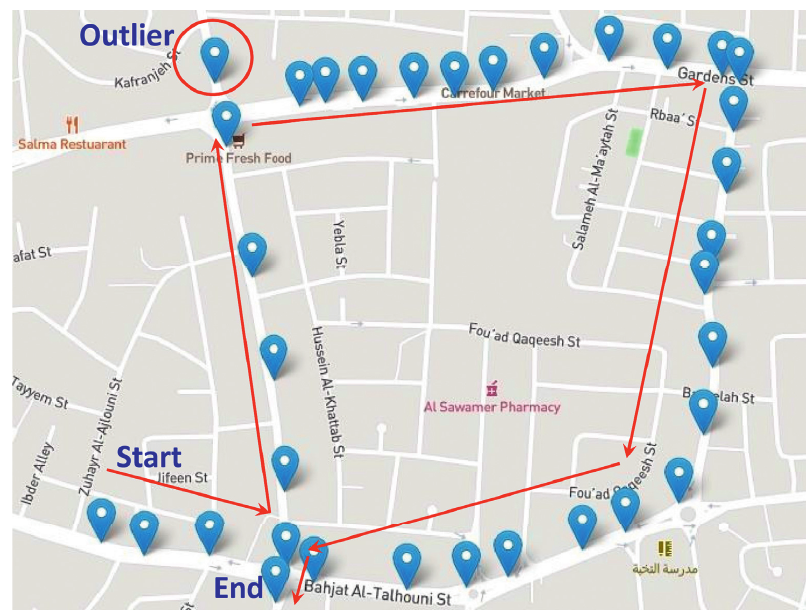
Figure 20: A trip path in which there is one outlier marker.